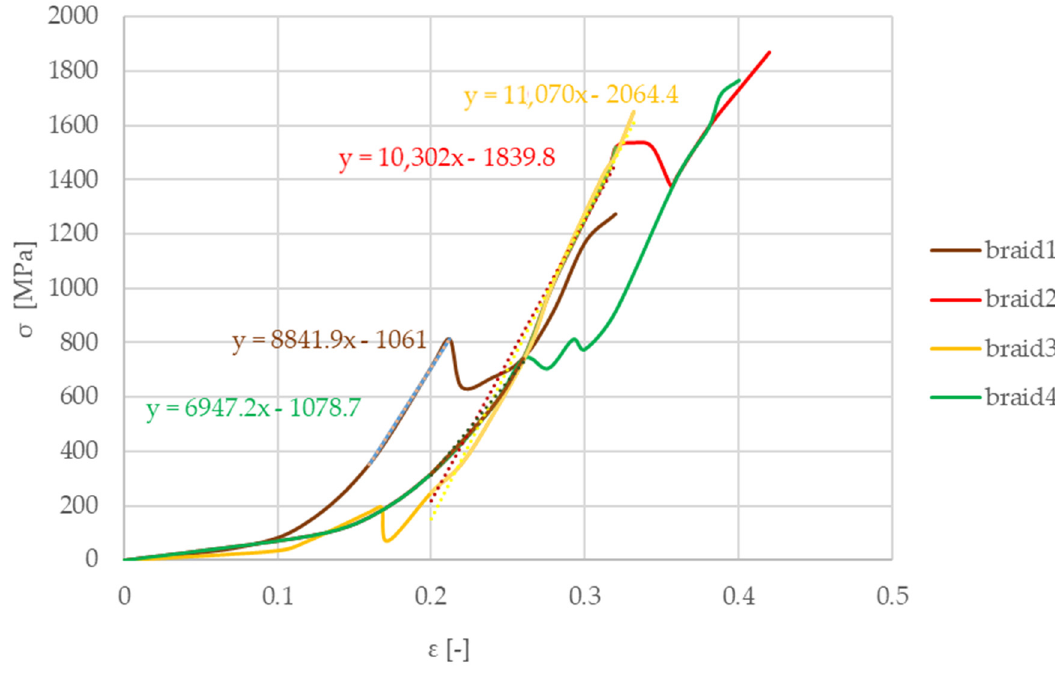
Figure 15. Stress–strain curves of woven braids (yarn) from the long fiber reinforcement group.